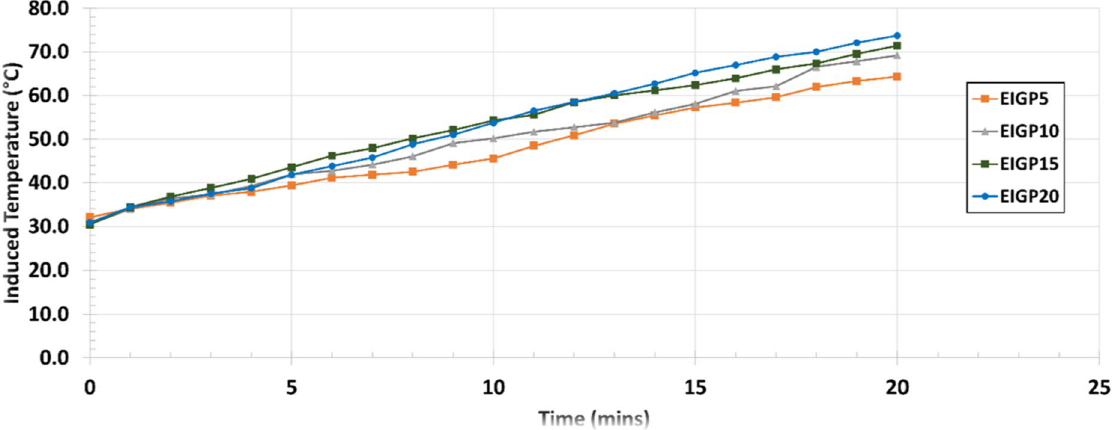
Figure 2. Induced heating temperature using EMF curing method.